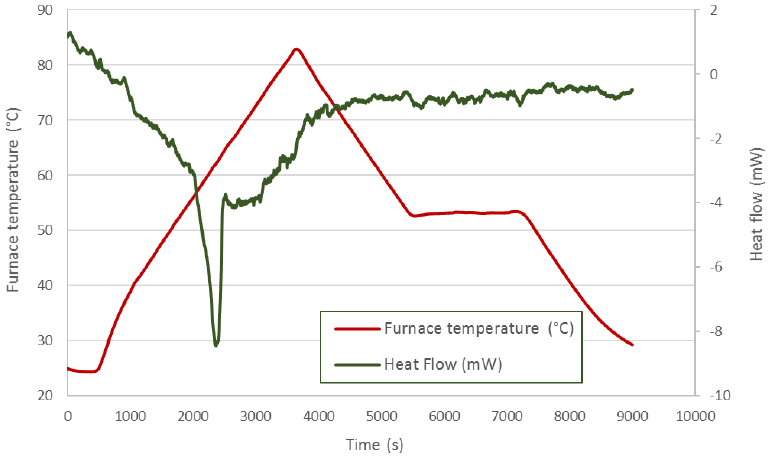
Figure 7. HD60 DSC analysis.